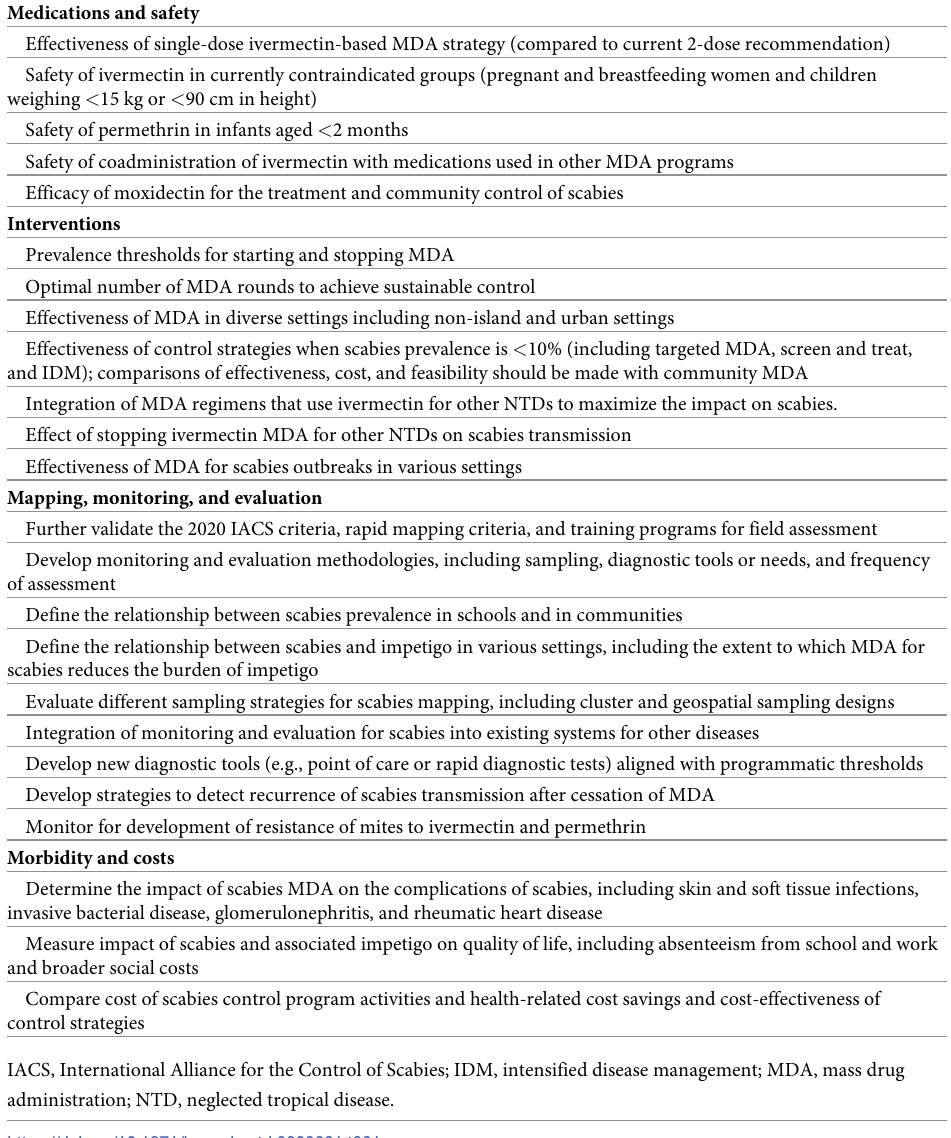
Table 1. Priority research issues for scabies control. Medications and